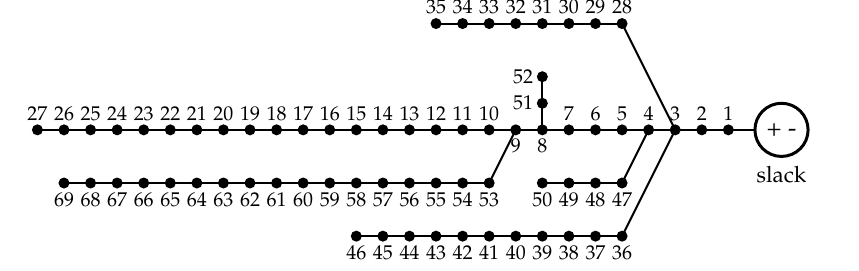
Figure 4. Grid configuration of the 69-bus test system. Table 2. Branch and load information of the 69-bus test